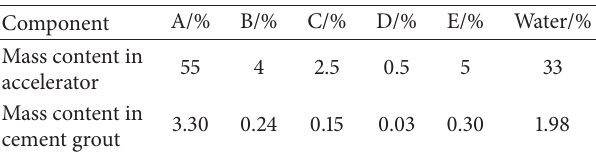
Figure 6: Setting time of cement grout mixing with modified mother liquor and Material E.